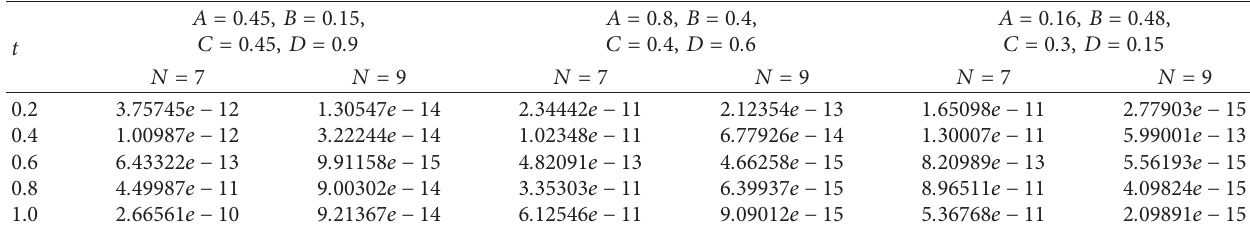
in Example 3. 1 ,N